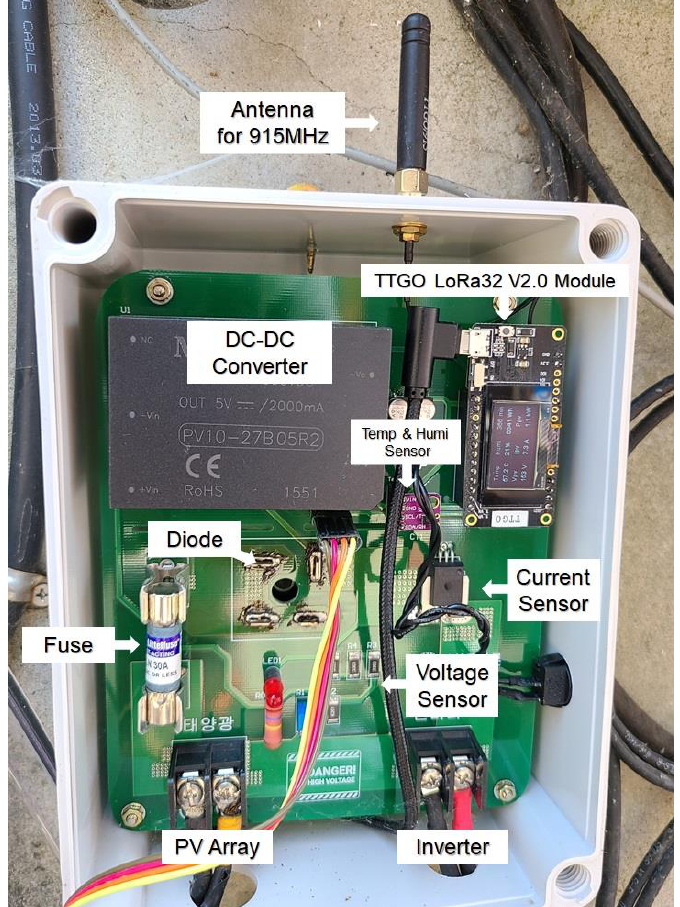
Figure 7. The assembled PV junction box with TX module.